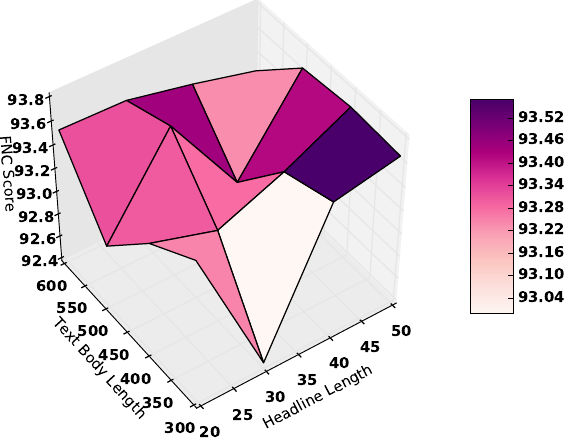
Figure 3. Length of news headline and text body and performance of a